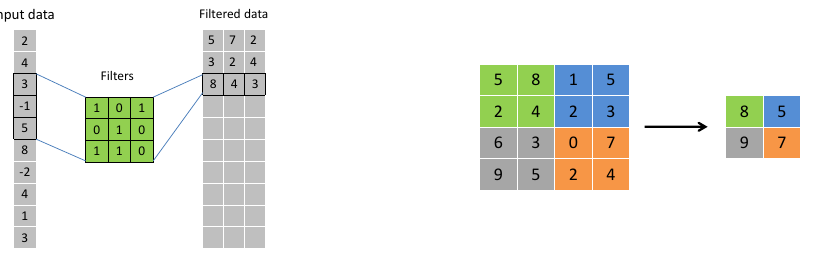
Figure 2: Example of convolution (left) and max pooling (right) operations used in